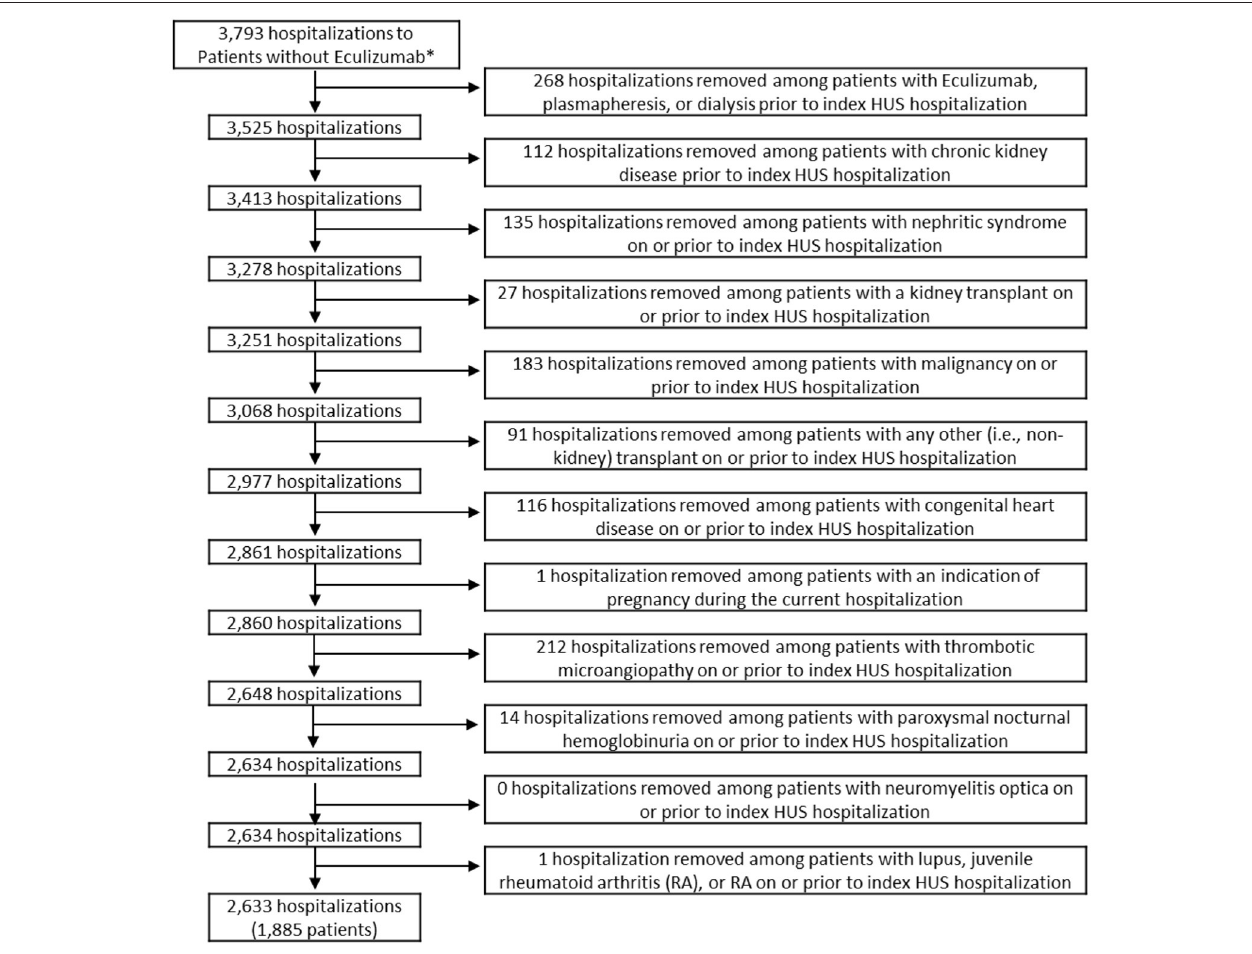
(Tableau Software LLC, Seattle, WA). All tests were two-sided assuming a p- value < 0.05 as statistically